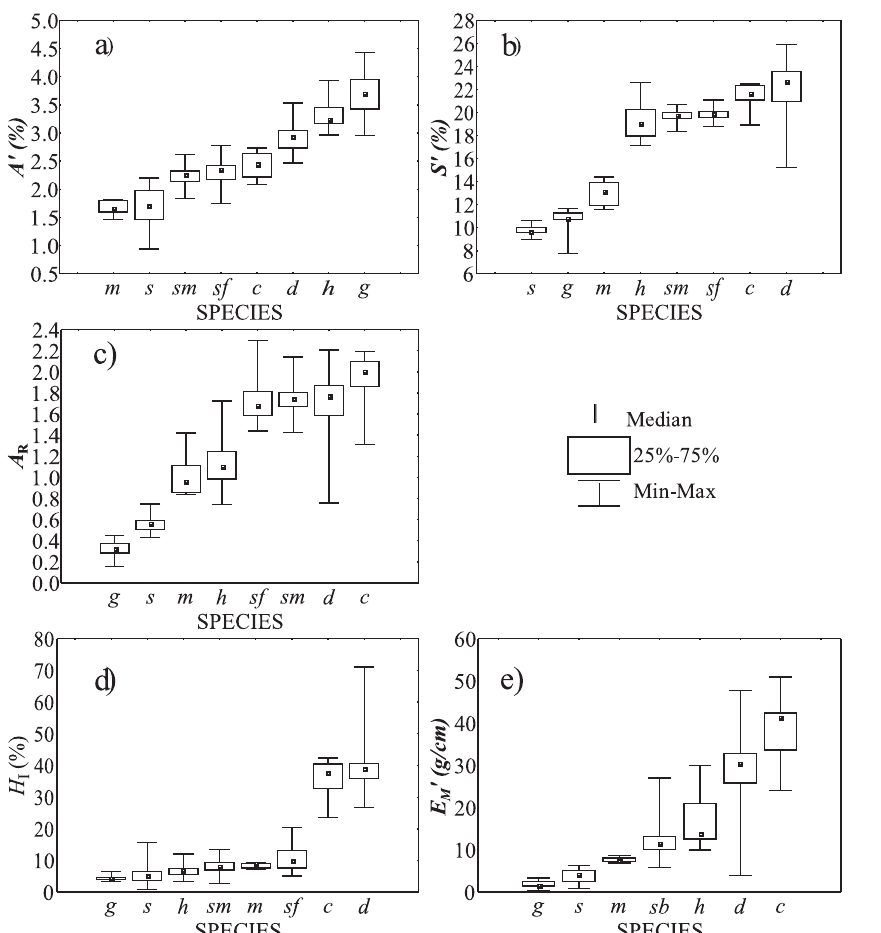
Fig . 5. – box-plots showing median values (empty squares), first and third quartiles (empty rectangles) and minimum-maximum values (error bars) for body size-standardised caudal fin area ( A’ , plot a), body size-standardised caudal fin span ( S’ , plot b), caudal fin aspect ratio ( A , plot r ’ , plot e) in Galeus melastomus ( g ), Scyliorhinus can- c), hepatosomatic index ( H , plot d) and muscular-skeletal amount per unit length ( E i m icula ( s ), Heptranchias perlo ( h ), Squalus blainvillei ( sbm : males; sbf : females), Mustelus asterias ( m ), Centrophorus uyato ( c ) and Dalatias licha ( d ). in each plot, species are ranked according to increasing order of the median